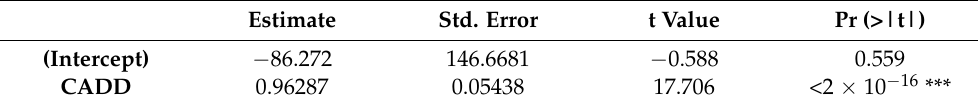
Table 1. Coefficients of the linear relationship between cumulative annual surface degree days >0 ◦ C of forest covers (CSDF) derived from Moderate Resolution Imaging Spectroradiometer (MODIS) images and cumulative annual degree days >0 ◦ C (CADD) derived from air temperature observed by meteorological stations in dominant vegetation areas. Estimate